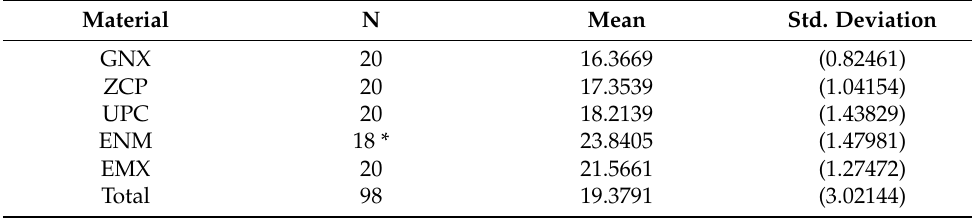
Table 5. Descriptive TP values for the non-aged groups. * Outliers were deleted.